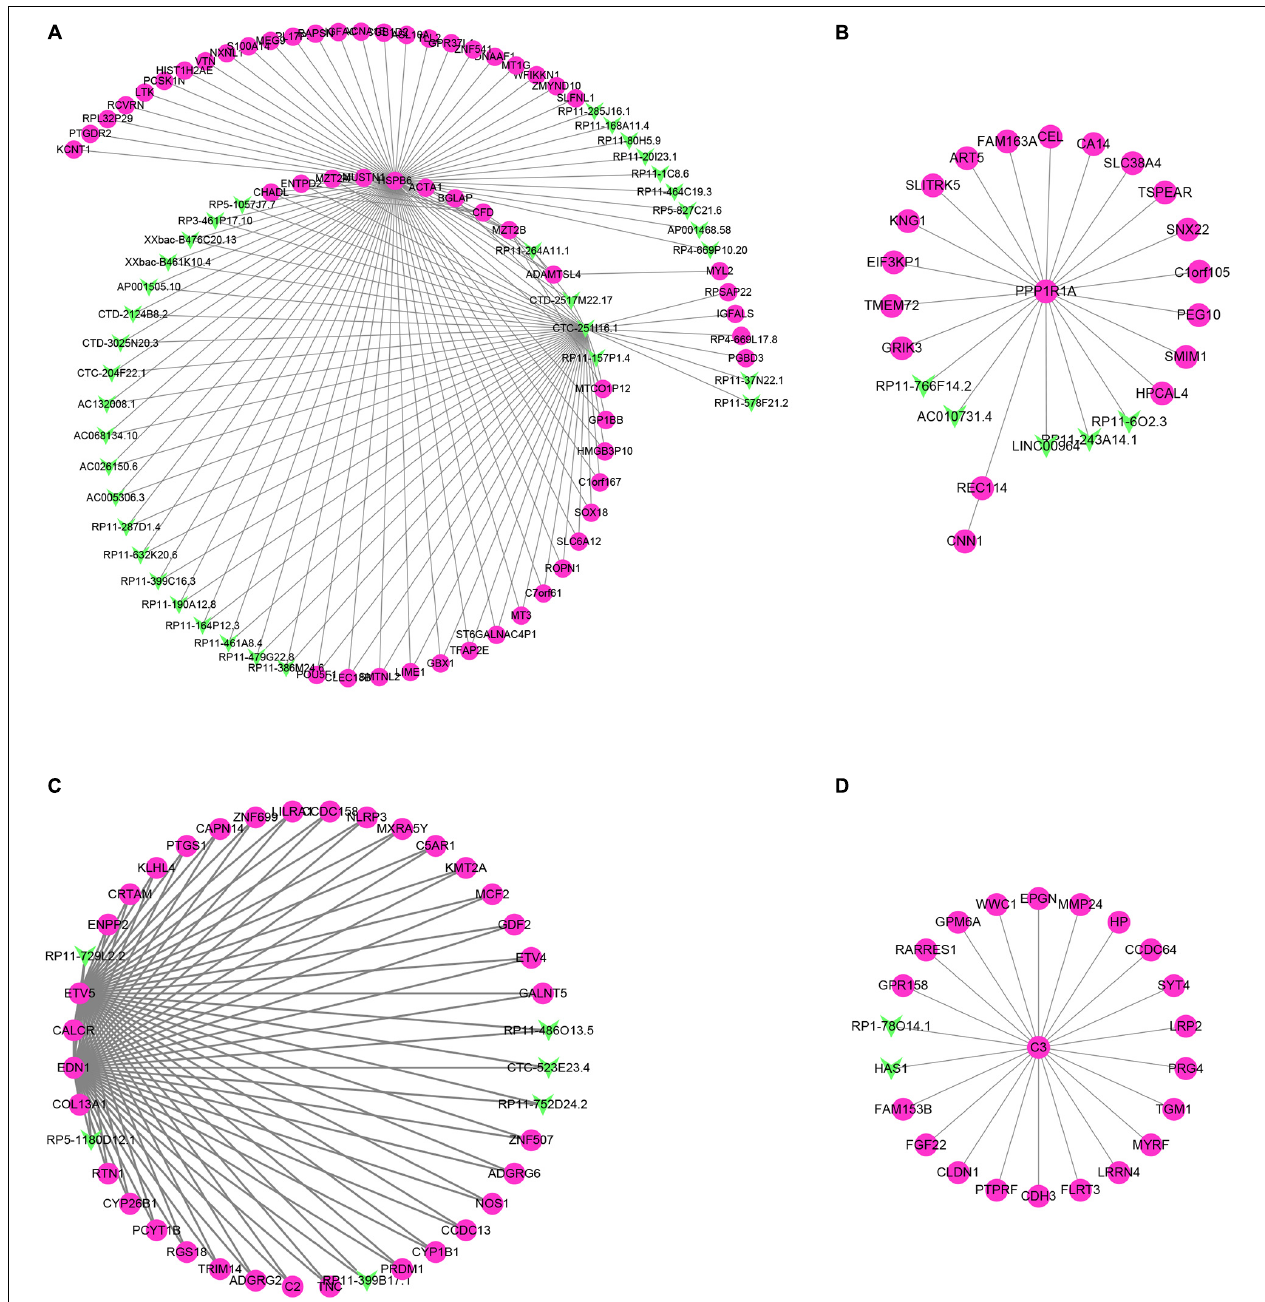
FIGURE 7 | Construction of lncRNA-mRNA interaction network in the hub modules. (A–D) The lncRNA-mRNA interaction network was built in blue module (A) , brown module (B) , turquoise module (C) , and yellow module (D) .